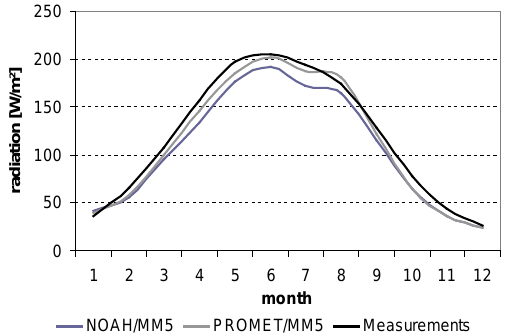
Fig. 6. Monthly mean temperature of 2-way coupled PROMET/MM5 and NOAH/MM5 simulations in comparison with measurements in the Upper Danube